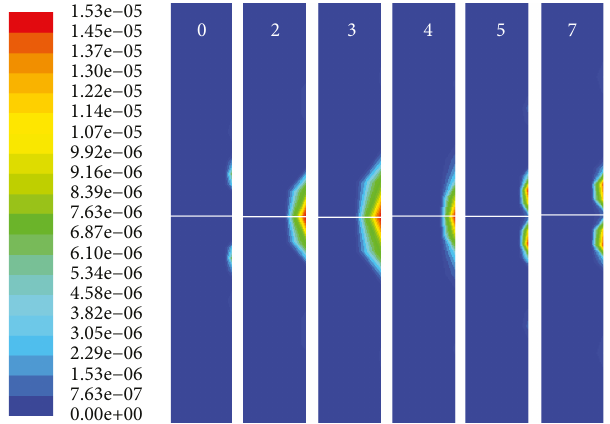
Figure 9: Erosion rate of rock at di ff erent throat aspect